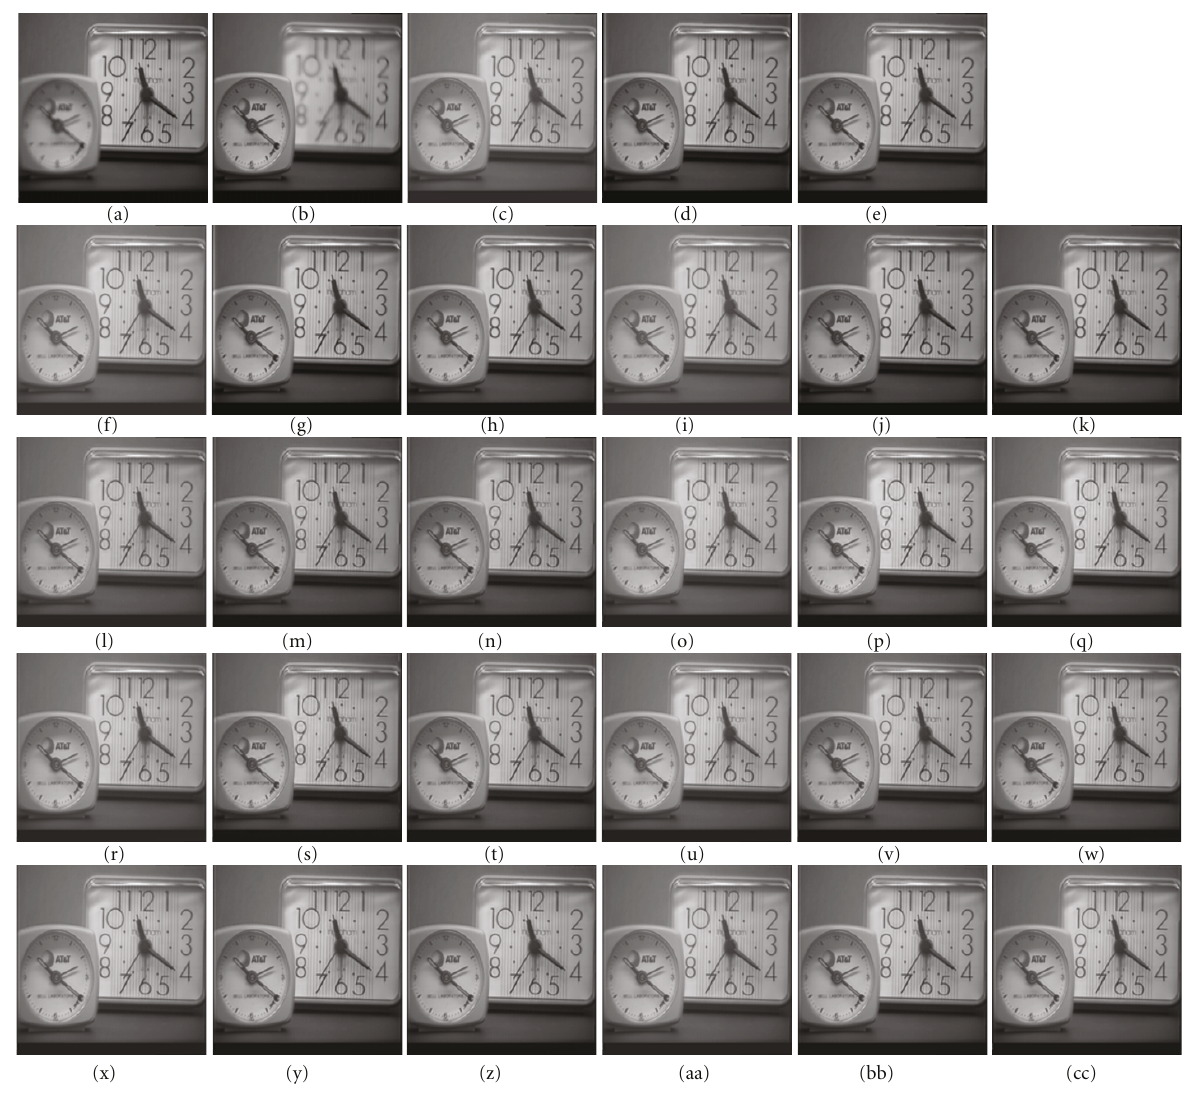
Figure 10: (a) and (b) Original “clock” source images, image fusion results using (c) LP/AM, (d) LIP-LP/AM, (e) PL-LP/AM, (f) LP/BK, (g) LIP-LP/BK, (h) PL-LP/BK, (i) LP/RB, (j) LIP-LP/RB, (k) PL-LP/RB, (l) DWT/AM, (m) LIP-DWT/AM, (n) PL-DWT/AM, (o) DWT/BK, (p) LIP-DWT/BK, (q) PL-DWT/BK, (r) DWT/RB, (s) LIP-DWT/RB, (t) PL-DWT/RB, (u) SWT/AM, (v) LIP-SWT/AM, (w) PL-SWT/AM, (x) SWT/BK, (y) LIP-SWT/BK, (z) PL-SWT /BK, (aa) SWT/RB, (bb) LIP-SWT/RB, (cc)